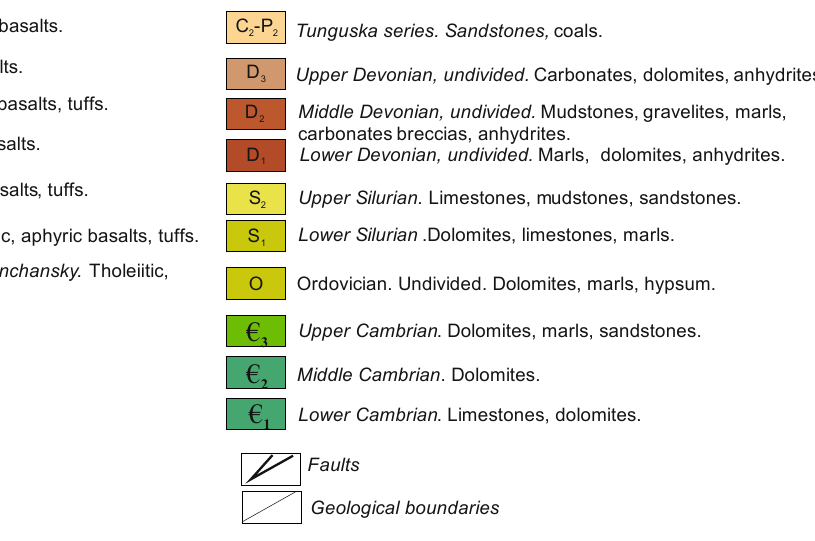
Figure 2. Geological map and cross ‐ sections of the studied area. Figure 3. Cross ‐ section the Vologochan syncline. Captions in Figure 2. between the basalt flows. The total thickness of the formation is 160 m.